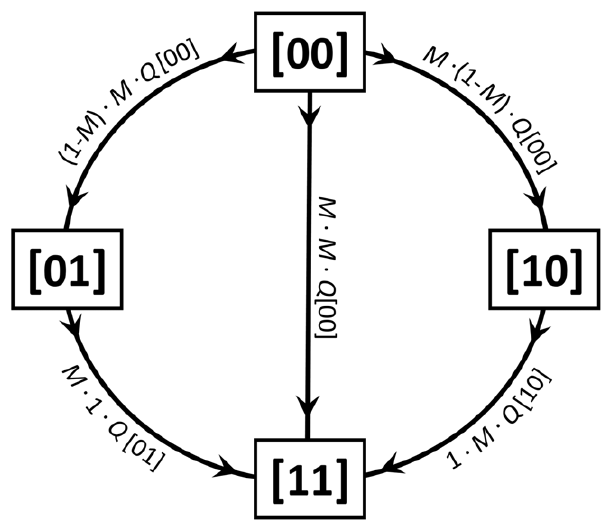
Figure 1. Illustration of changes in frequencies of particular genotypes due to mutations for the exemplary 2-locus case. The mutation rate per locus is constant and equals M . Backward mutations are neglected. For example, genotype [10] can only mutate into genotype [11] (with probability M ) or remain the same (with probability 1 2 M ). The probability of changing the genotype is multiplied by current frequency of the respective genotype to calculate the new frequency. The frequency of each genotype decreases due to mutations in this genotype and increases due to mutations in other genotypes. The change in frequency of genotype [10] is equal to the inflow from genotype [00] minus the outflow to genotype [11] ; thus the new frequency Q *[10] equals Q [10] + M ? (1 2 M ) ? Q [00] 2 1 ? M ? Q [10] . 2-locus case is shown for simplicity, but at least 10 locus cases are considered in the